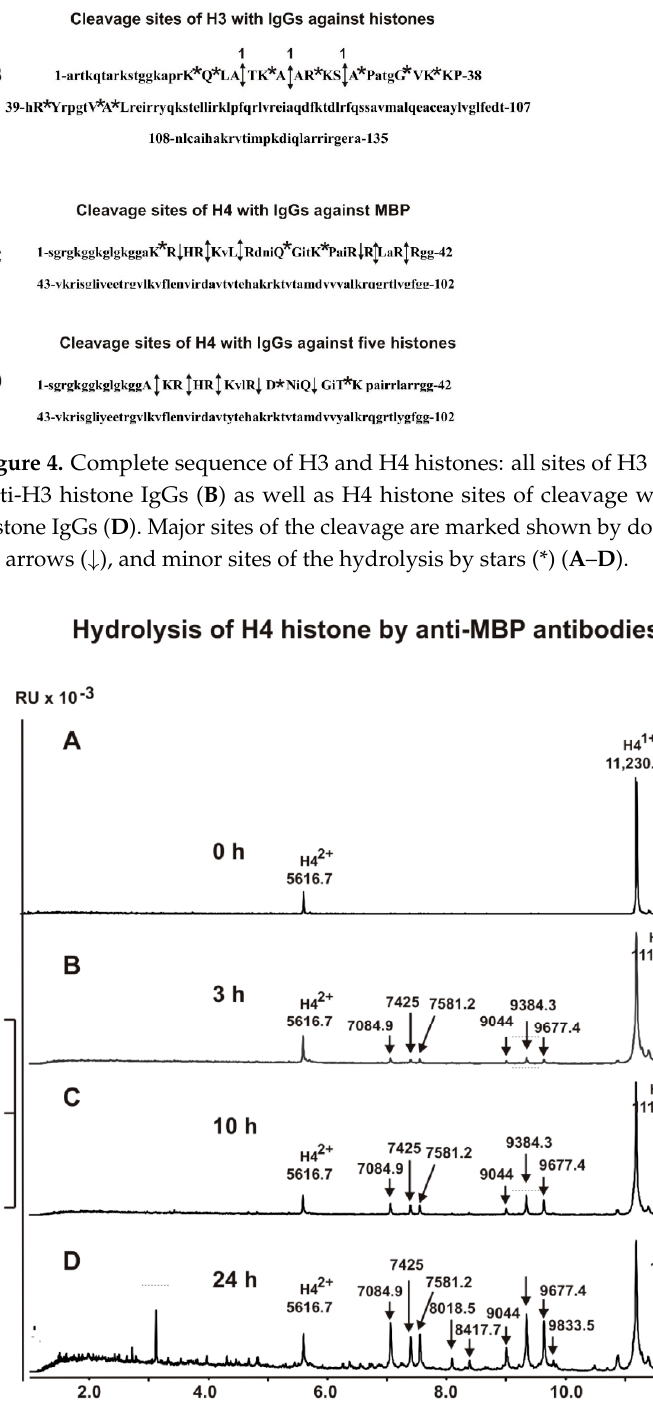
Figure 5. MALDI spectra ( A – D ) corresponding to H4 histone (1.0 mg/mL) over time hydrolysis (0– 24 h) by anti-MBP IgGs (5.0 µg/mL). (0–24 h) by anti-MBP IgGs (5.0 µ